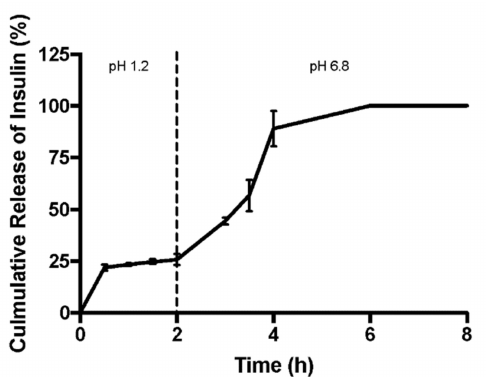
Figure 4. Release assay for the double-coated insulin-loaded NPs in acidic medium until 2 h and conducted in neutral medium from 2 to 8 h, mimicking the pH range of the gastrointestinal tract